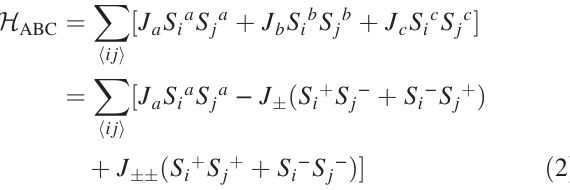
) mag to obtain p . An mag